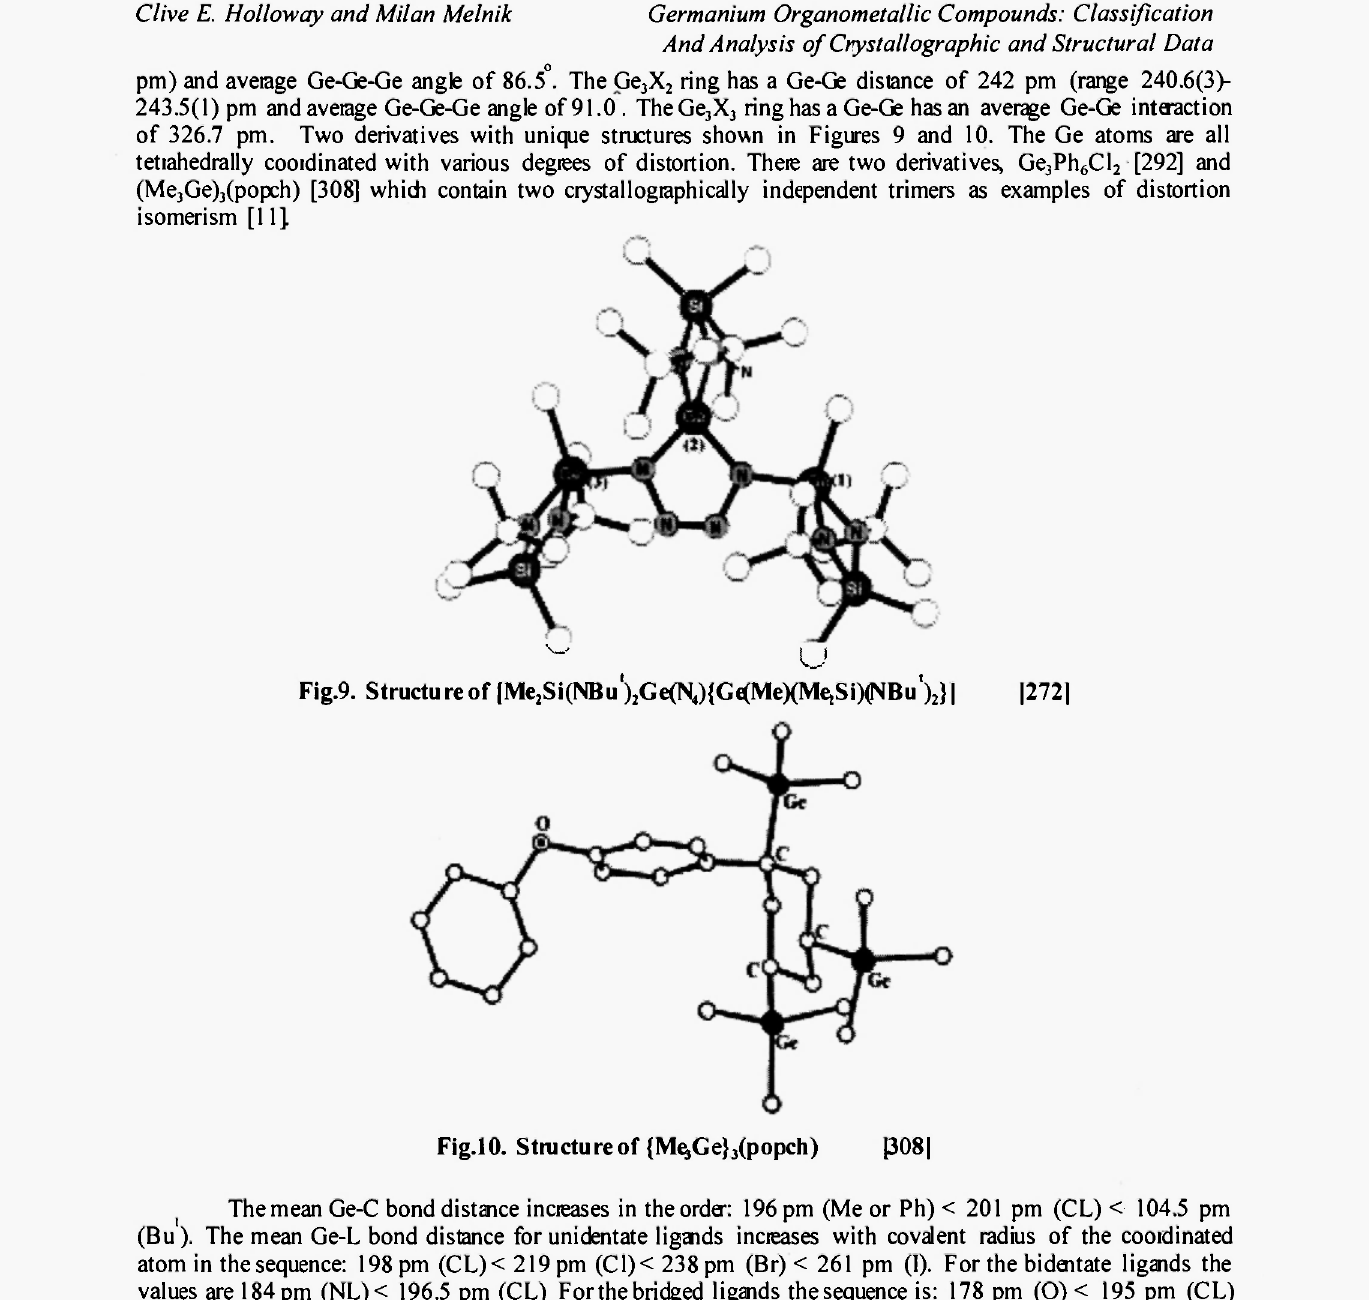
Fig.10. Structure of {M^Ge} 3 (popch)